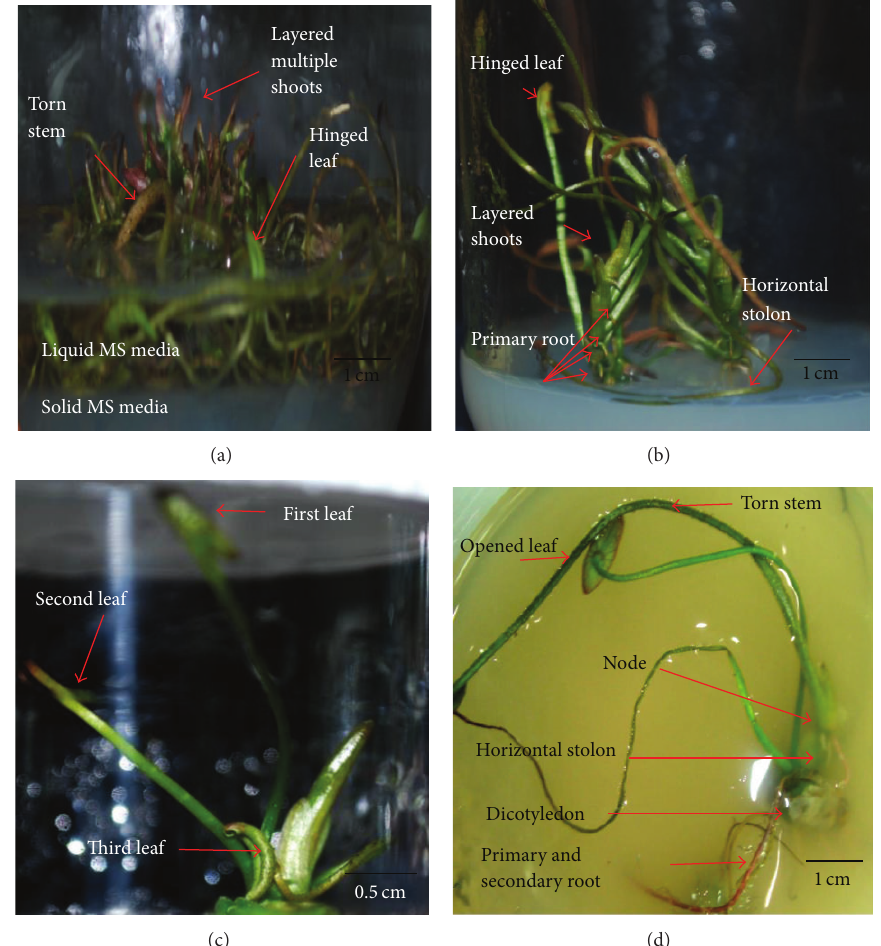
Figure 4: Comparison of plantlets morphology of N. nucifera from various conditions of growth. (a) In vitro multiple shoots with new shoots characteristic from immature explants (yellow plumule) on double-layered MS media. (b) Layered multiple shoots transferred to solid MS media for root formation. (c) Normal shoots elongated on MS media for root formation. (d) In vivo grown lotus after 4 months.